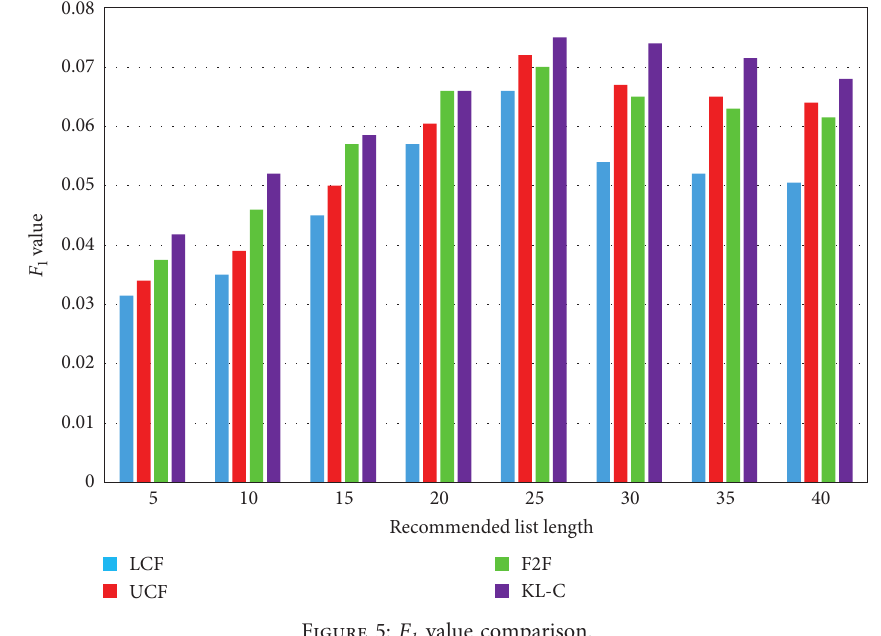
Figure 5: F 1 value comparison.